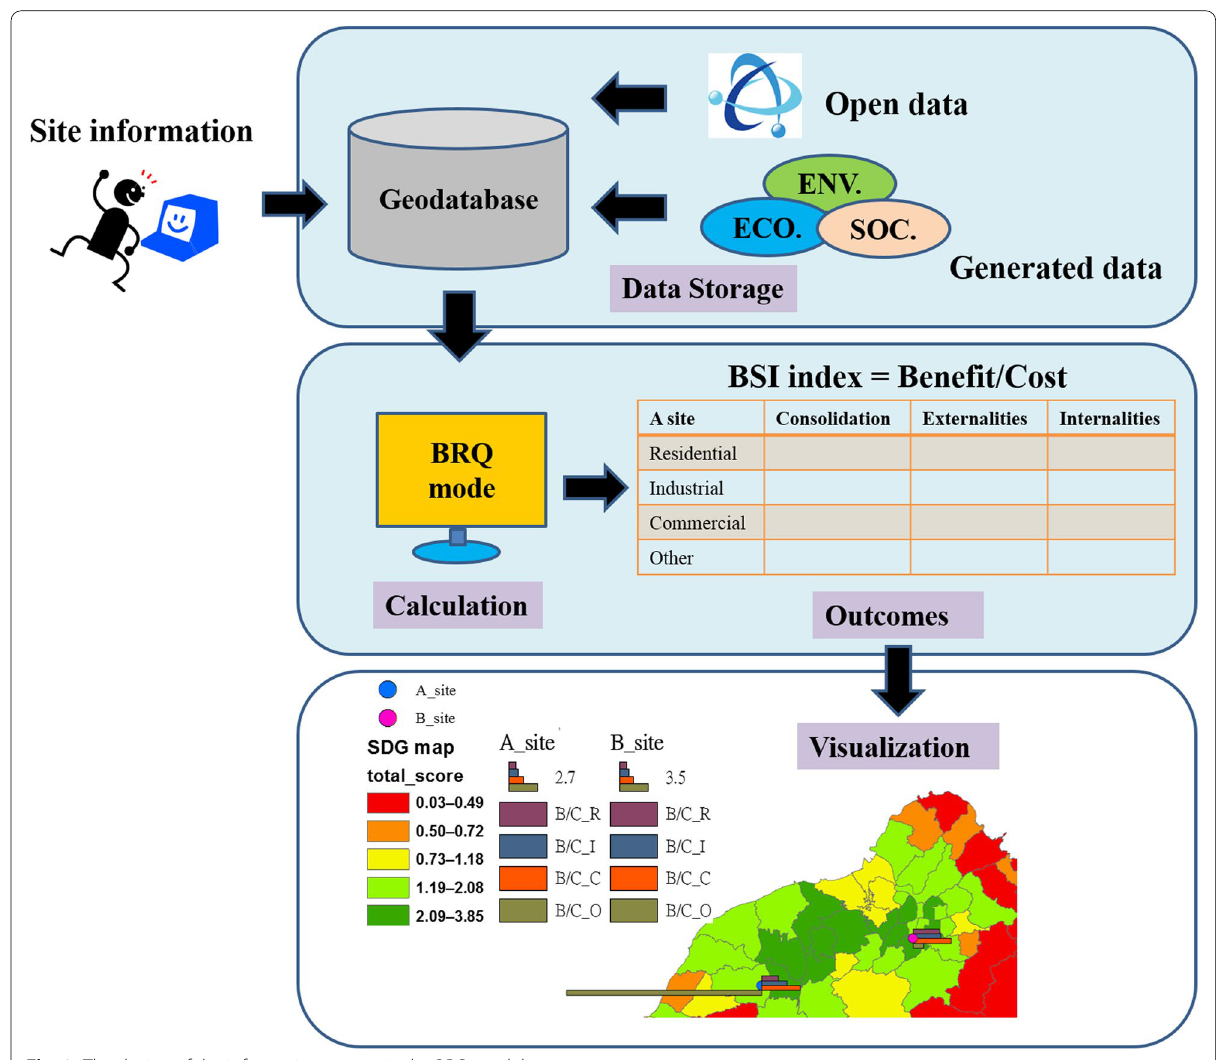
Fig. 2 The design of the information system in the BRQ